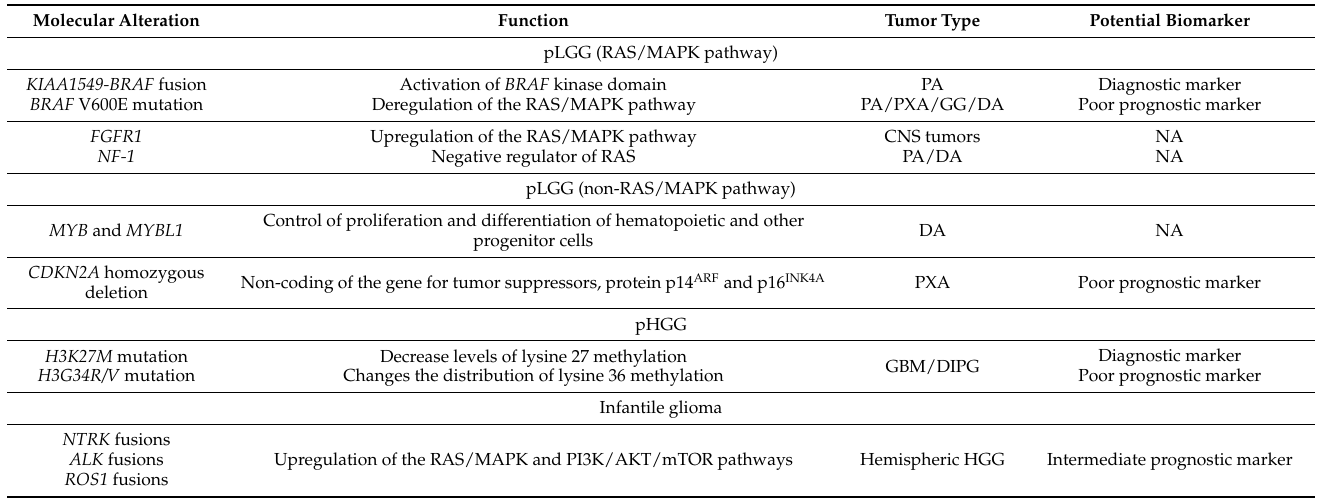
Table 1. Summary of molecular landscape in pediatric